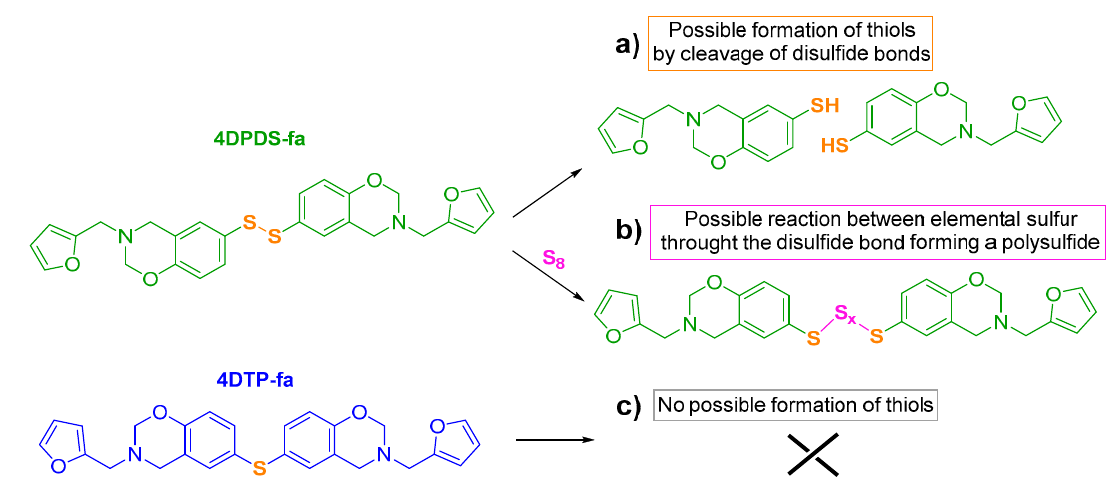
Scheme 3. Schematic representation of disulfide cleavage for 4DPDS-fa: ( a ) in the absence of sulfur, and ( b ) in presence of sulfur in comparison to ( c ) 4DTP-fa.